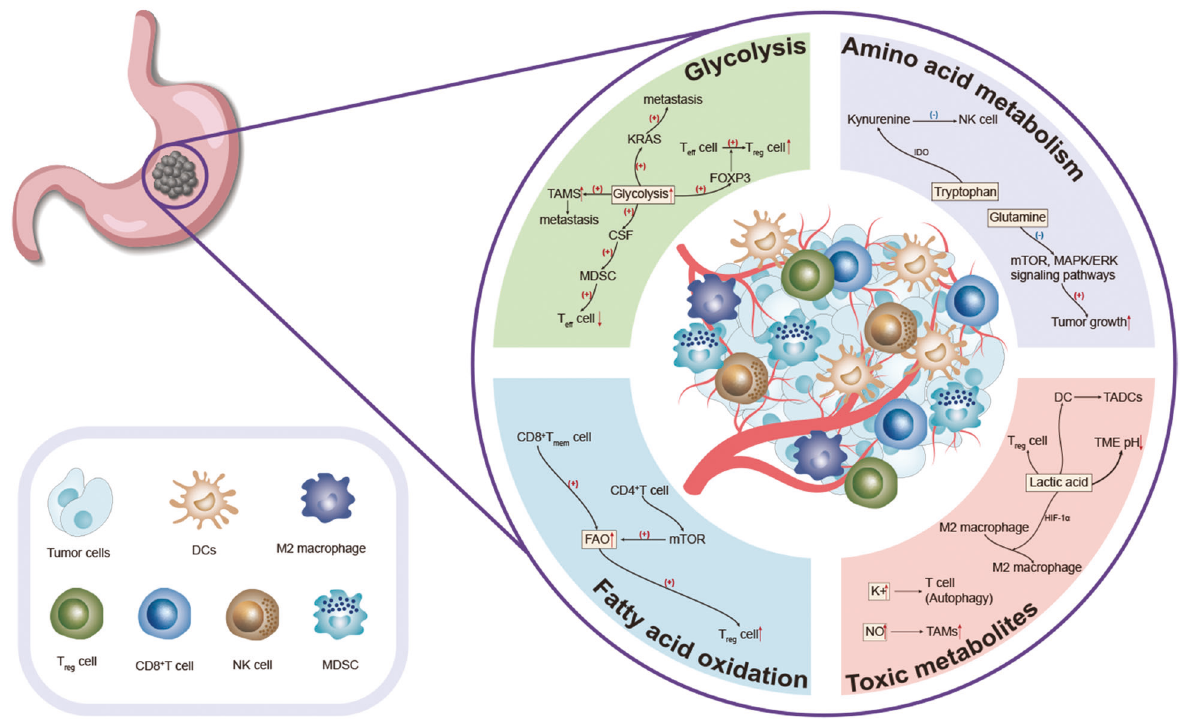
Fig. 1 Overview of the TME. The TME is the environment that tumors depend on for survival and is often described as low oxygen, low pH, and various metabolic changes — enhanced glycolysis, abnormal amino acid and fatty acid metabolism. These changes also led to changes in immune cells in the microenvironment, with an increase in various tumor-related immune cells and a decrease in inhibitory cells — more TAMs, tumor-associated dendritic cells (TADCs), Treg and M2-like macrophages, fewer Teff cells, and more CD8 + Tmem cells, and various toxic metabolites glutamine, canine urine, and lactic acid also